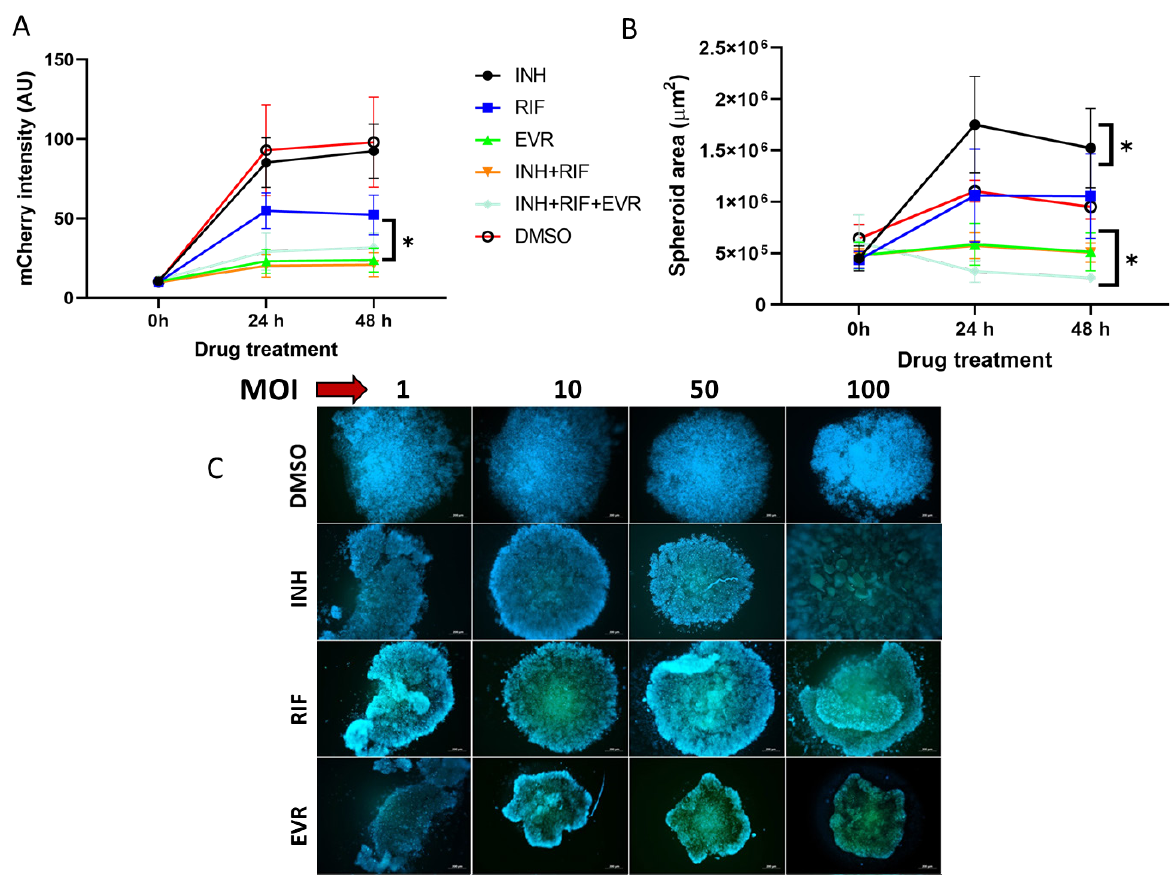
Figure 2: Evaluating drug response using Image cytometry. (a) mCherry intensity and (b) area for spheroids infected with BCG mCherry at MOI 100 quantification post drug treatment with control DMSO (0.5%v/v), single-drug treatment with isoniazid (INH 1.25 µM), rifampicin (RIF 0.195 µM), Everolimus (EVR 1nM) and combination of INH, RIF and EVR (0.625 µM INH, 0.195 µM RIF and 1 nM EVR). * denotes statistical significance compared to DMSO at both 24 and 48 h time point using two-way Anova, p<0.05, n=3 samples/condition (c) Left to right shows increasing MOI of BCG and top to bottom shows Control, INH, RIF and EVR treated spheroids. Spheroids were stained with CYTO-ID autophagy dye (green) and Hoechst